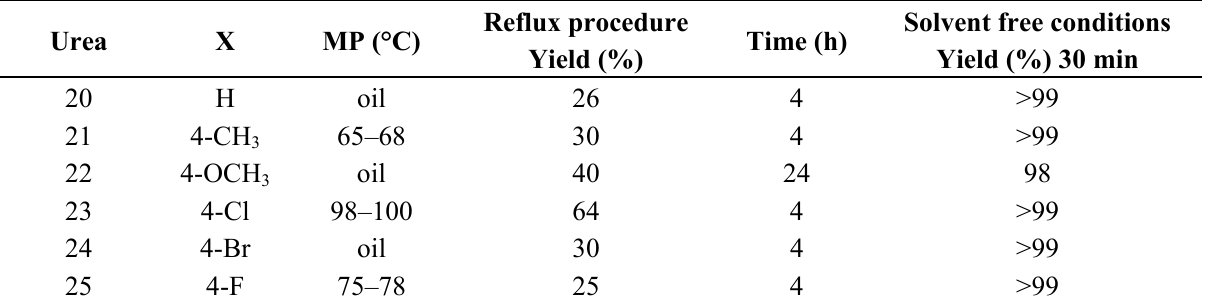
Reflux procedure Solvent free conditions Yield (%) 8–10 h Yield (%) 30